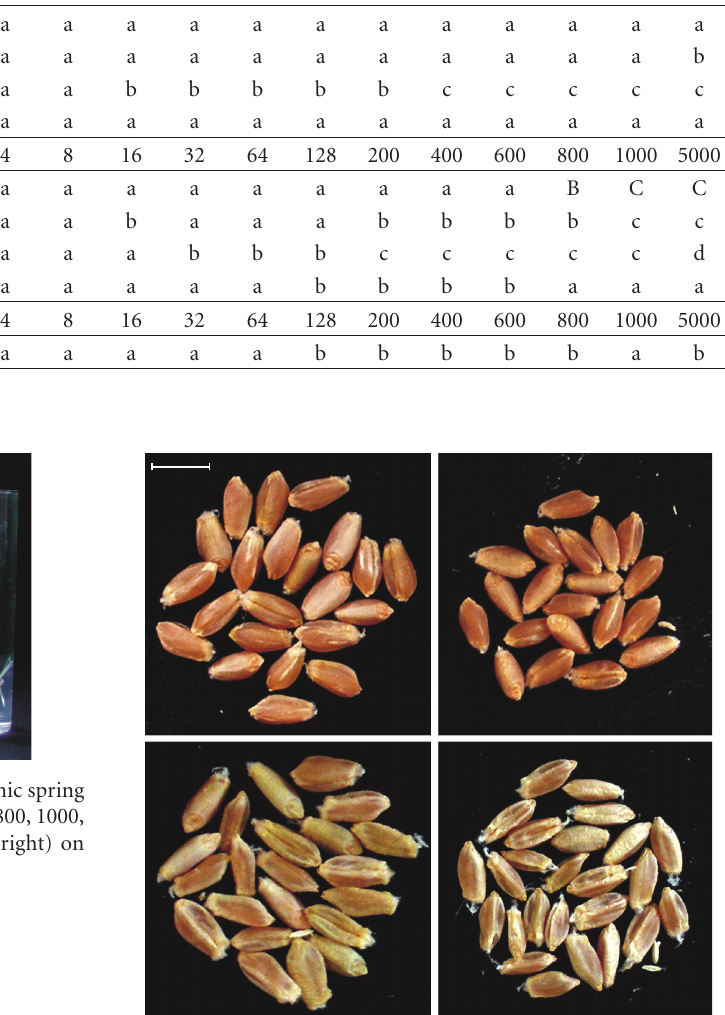
Figure 5: Grains of the well-filled (on the top) and the low-filled spikes (on the bottom). Control (on the left) and 5000 mg · L − 1 (on the right) treatments resulted in di ff erent size and exterior of grains. bar ∗